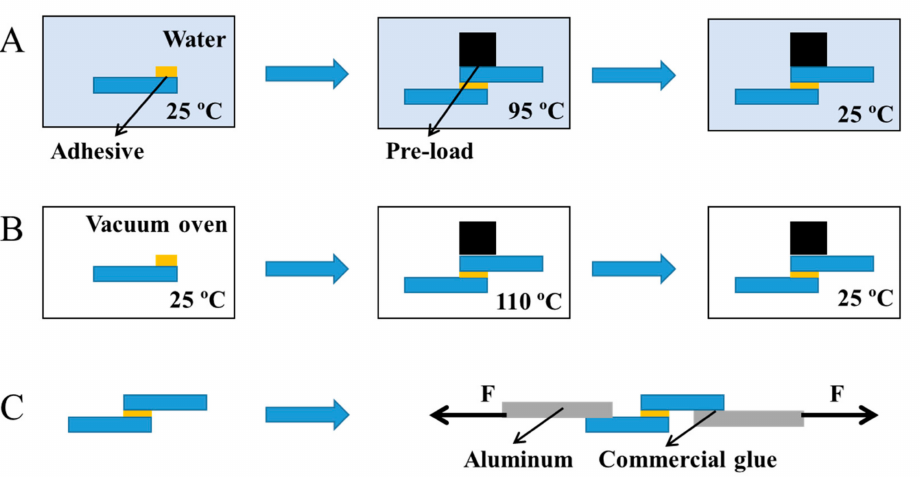
Figure 3. Preparation of bonded sample ( A ) under water and ( B ) vacuum conditions. ( C ) Schematic illustration of shear adhesion test.